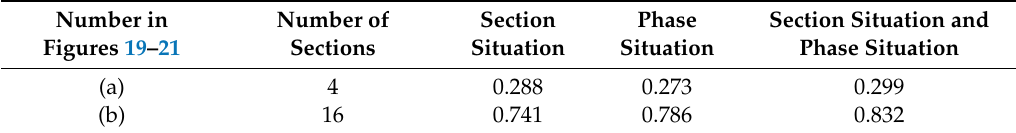
Table 17. Comparison of the means of curves.